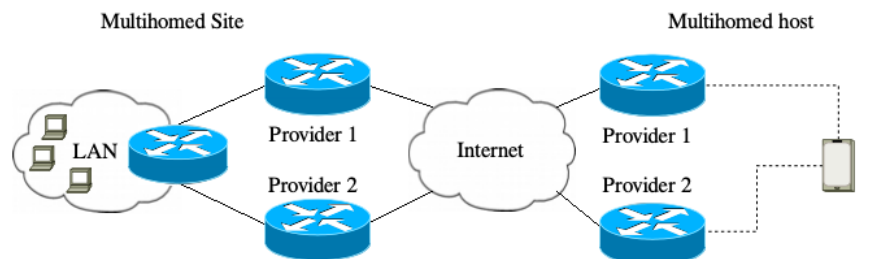
Figure 2. Site-Wide Multi-homing Example [1].